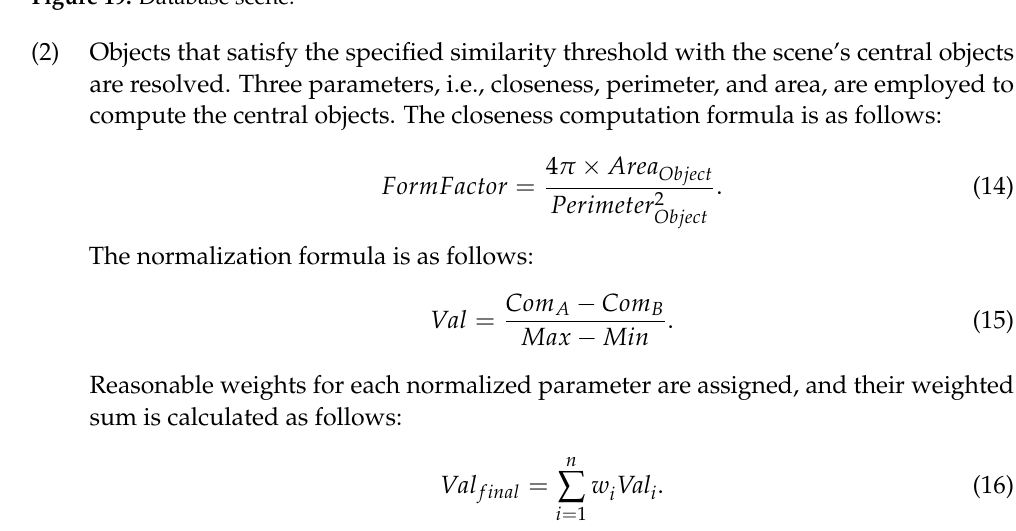
Figure 19. Database